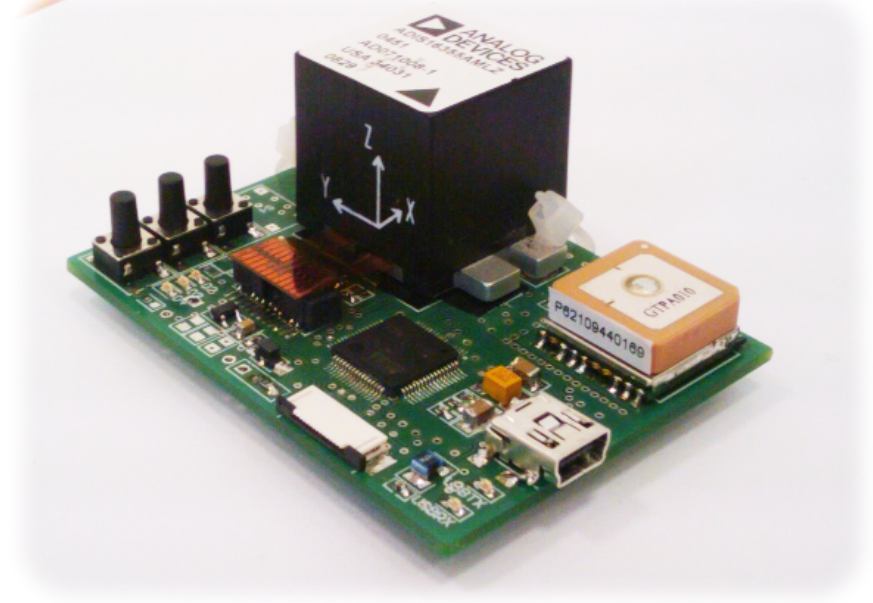
Figure 2. A picture of the built electronic module. The black box is a 6DOF sensor—3-axial gyroscope and 3-axial accelerometer. The orange cuboid is an antenna of a GPS receiver. The module is connected with the PC through a mini-USB